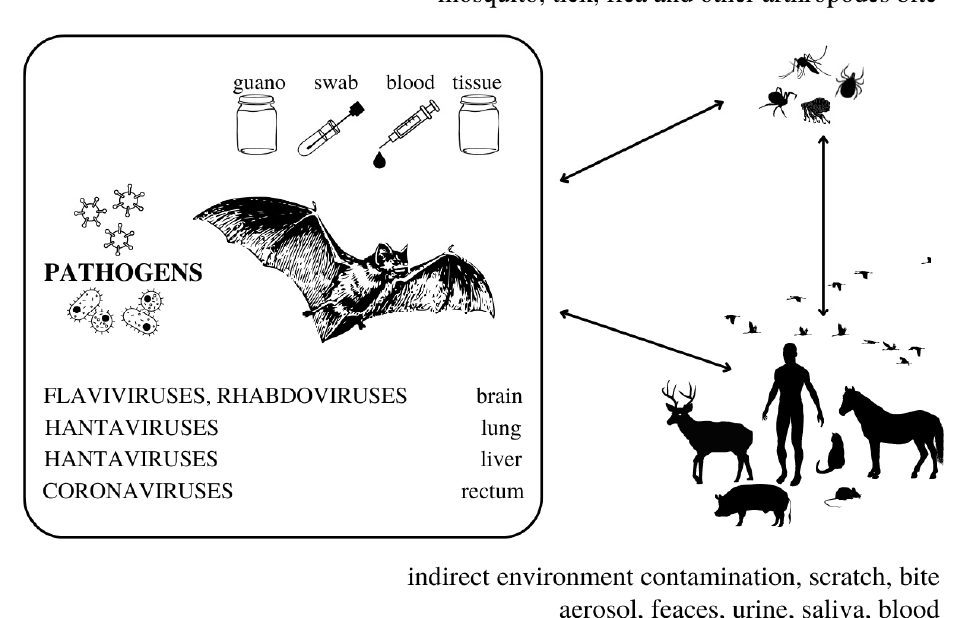
Figure 1. The complexity of bat-borne pathogens transmission. The information in this figure was compiled using studies cited in this review.